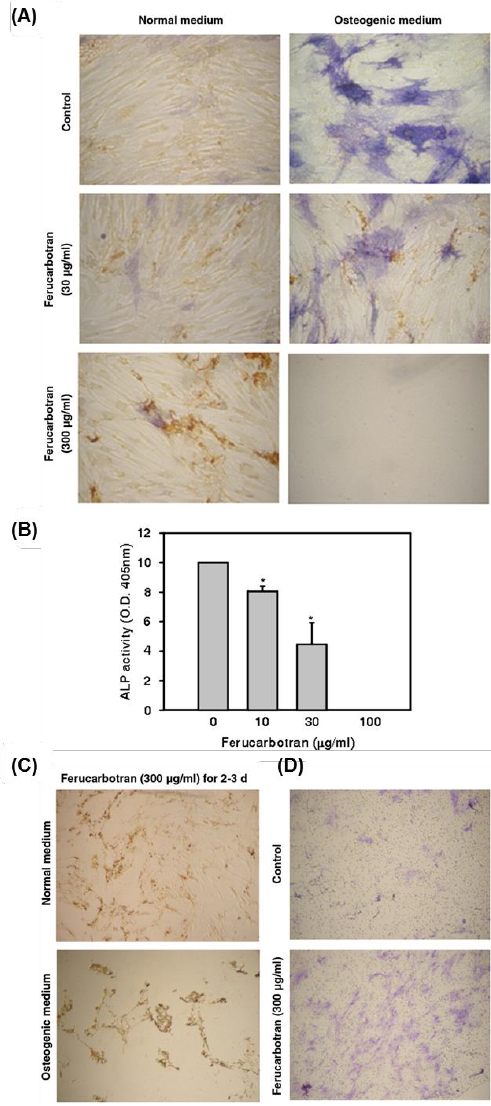
Figure 6. hMSC labeled with Ferucarbotran showed a dose-dependent suppression of the osteogenic differentiation and high cell migration. ( A ) Ferucarbotran (300 µ g/mL) suppressed the osteogenic differentiation of hMSC that shown in weak ALP staining. ( B ) The quantitative analysis of the ALP using the microplate reader and the absorbance was taken at 405 nm (* p < 0.05). ( B ) The quantitative estimation of ROS generation in ZnO NP-exposed MSCs represented in fluorescence units (* p < 0.05). ( C ) hMSC exposed to Ferucarbotran (300 µ g/mL) during the osteogenic differentiation for 2–3 days showed cell scattering and suspension, while cells adhered to the culture plate without migration under normal medium. ( D ) Cell migration assay was carried out using Transwell filters, showing the increased migration of Ferucarbotran-exposed cells for 24 h to the lower chamber that validated by the crystal violet staining. Reproduced from [188] with permission from Elsevier. Collectively, the impact of the metallic NPs on the proliferation and differentiation of various stem cells are summarized in Table